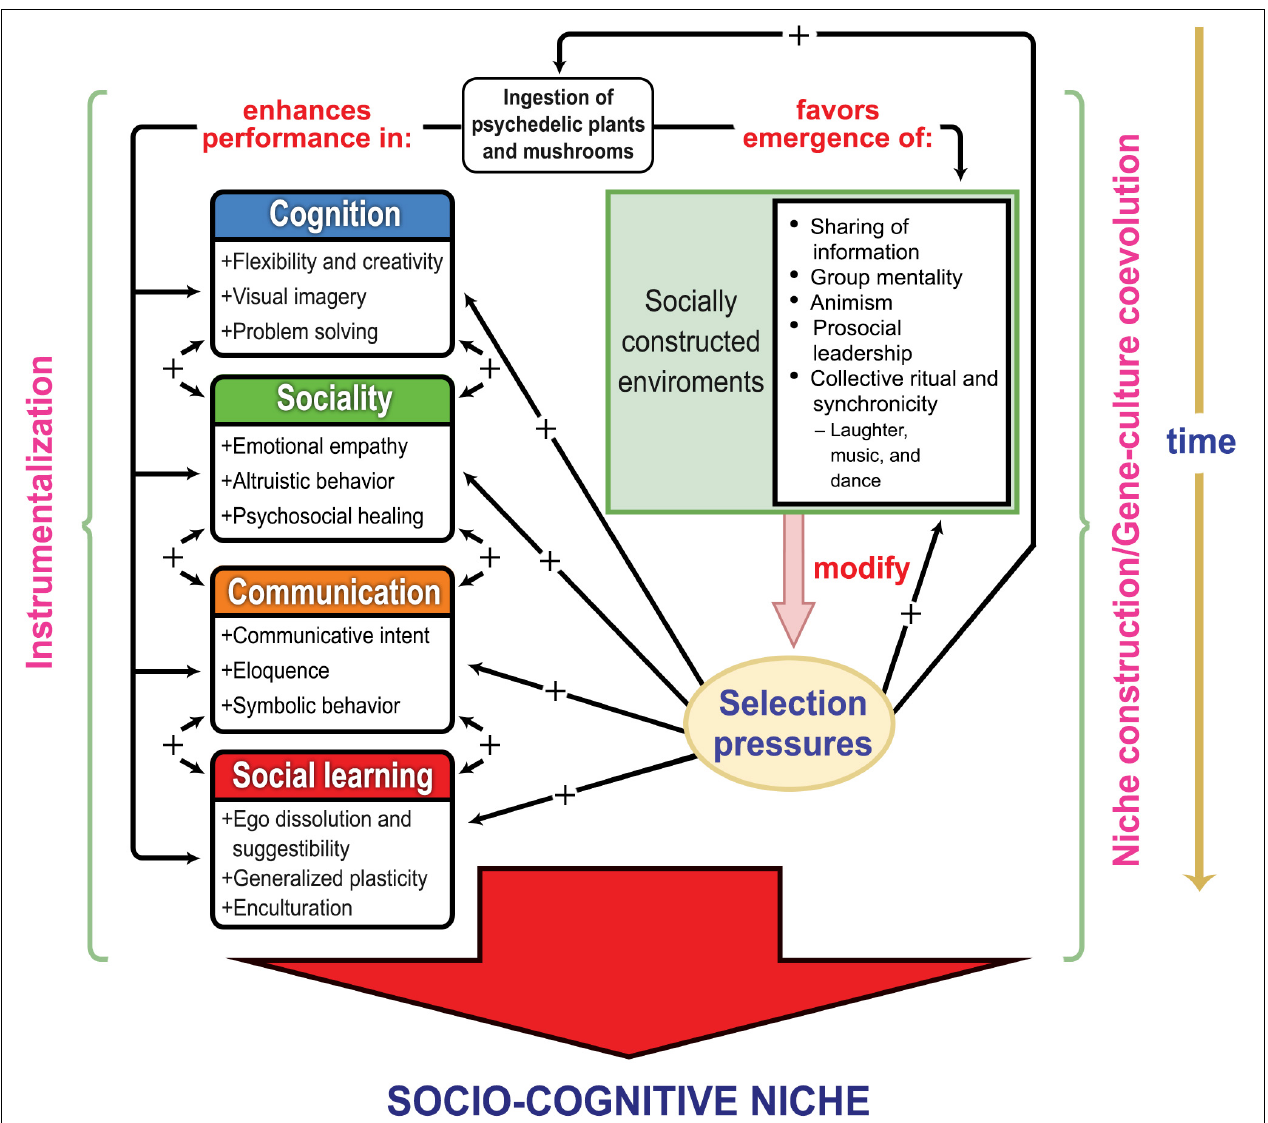
FIGURE 1 | A model of psychedelics instrumentalization by early humans, and of the evolutionary consequences of its intergenerational recurrence. The left side represents the process of instrumentalization, which can occur repeatedly across the life-span of a generation of hominins. The right side represents the process of niche-construction supporting gene-culture coevolution across generations as populations construct and bequeath transformed ecological and social environments that exercise selective influences on following generations (Odling-Smee et al., 2003). The left side of the diagram portrays potential selective advantages conferred by psychedelic use under the socio-ecological conditions in which our ancestors evolved. The right side illustrates the process of selective feedback through which psychedelic instrumentalization could have enhanced the creation and evolution of the human socio-cognitive niche. The four colored boxes on the left represent the major aspects of the emerging human adaptive complex that created the socio-cognitive niche; these involve skills and processes potentially amplified by psychedelic instrumentalization, with the two-directional arrows between the boxes representing the interconnectedness of these competence realms that coevolved in creating our unique adaptation mode. The emergence and persistence of this adaptive complex across human evolution permitted the progressive construction of socially modified environments (represented by the green box at the right side of the diagram) that in turn selected for enhancements in the same underlying human propensities and capabilities (represented by arrows with a plus [+] sign) that sustained the socio-cognitive